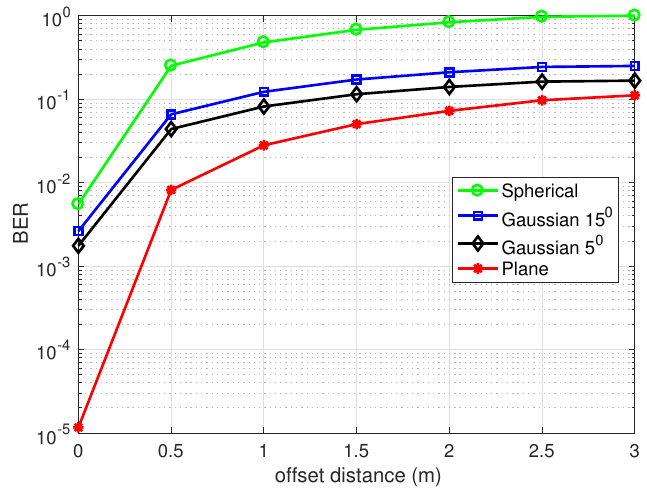
Figure 7. BER vs. offset distance r for plane, Gaussian and spherical beams in 10 m clean